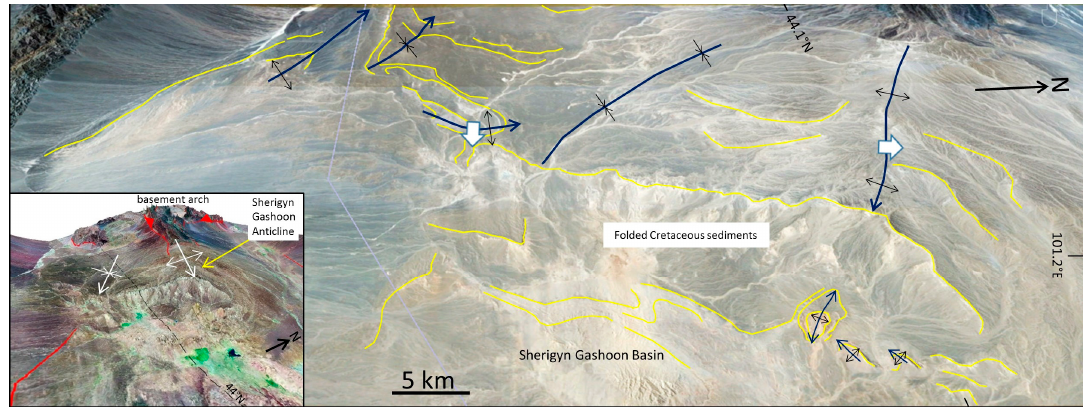
Figure 13. Google Earth (© 2016 DigitalGlobe) image interpretation showing bedding traces (yellow lines) and major fold hinges in Cretaceous basin fill, Sherigyn Gashoon Basin, central Gobi Altai. Thick white arrows indicate direction of fold vergence. Inset shows vertically exaggerated (3 × ) DEM with Landsat TM image drape of main Sherigyn Gashoon anticline which is passive response to upthrusted basement block along-strike to west. See Figure 1 for location.